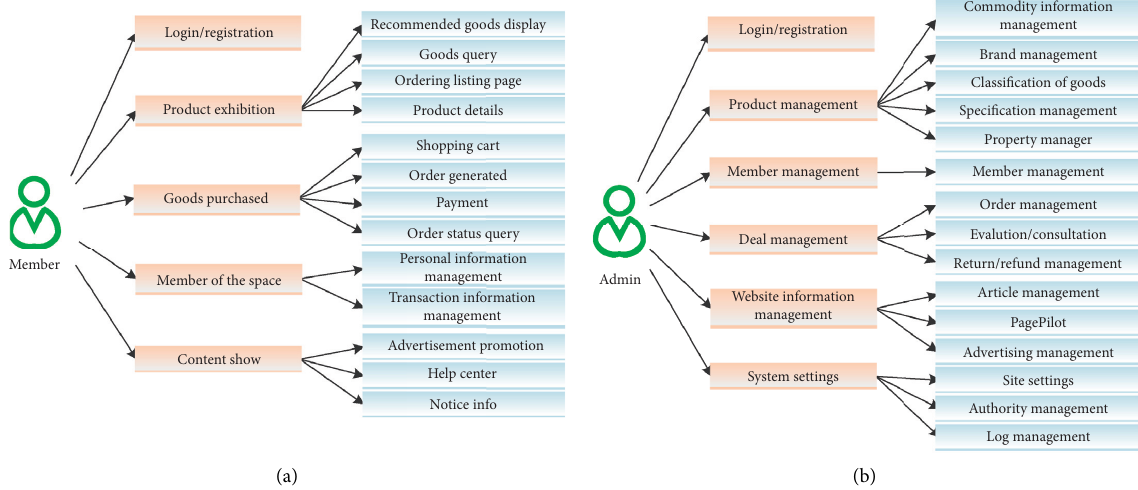
Figure 5: Front-stage shopping system and background management system function modules. (a) Front desk shopping system. (b) Backstage management system.